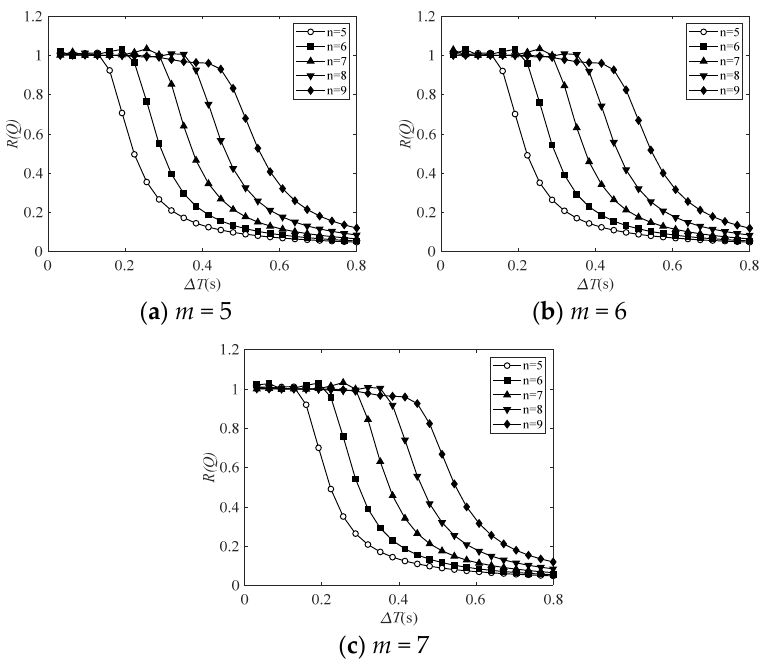
Figure 5. The relationship between spectral radius and time step.